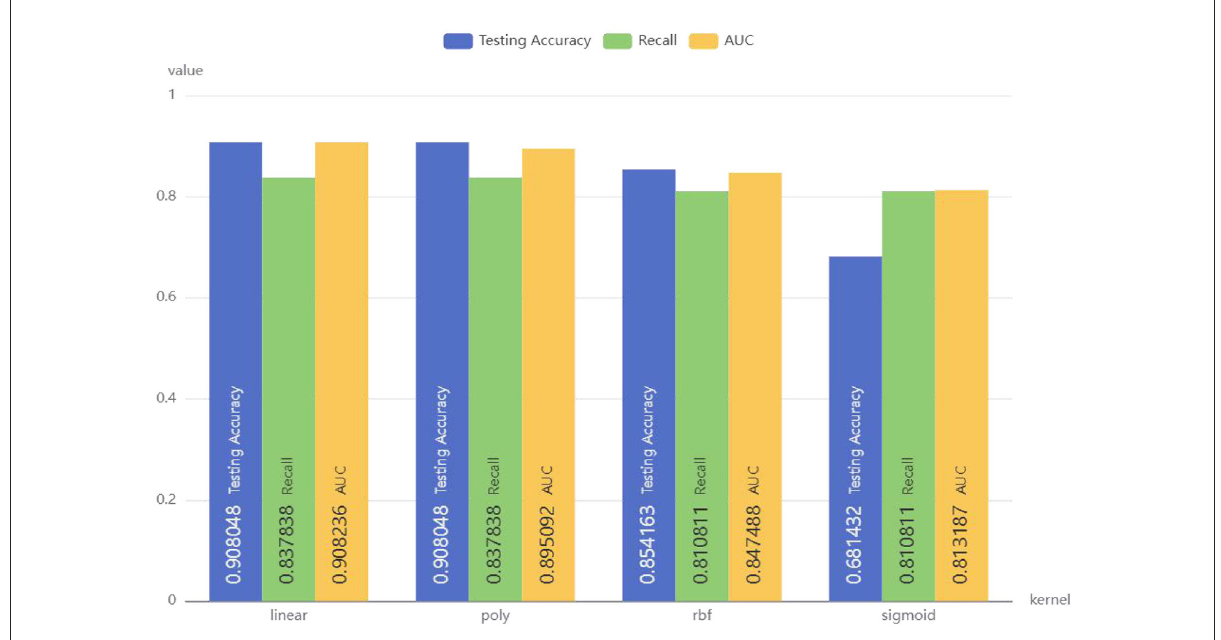
FIGURE5 Performance of SVM models with different kernel functions.